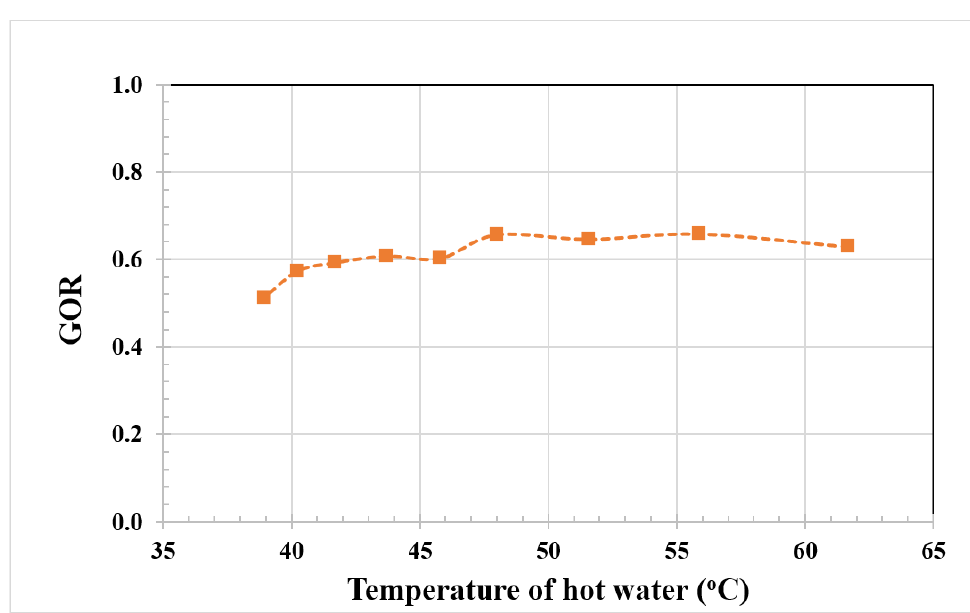
17 of 20 Figure 15. Energy intensity versus hot seawater temperature at two levels of seawater flow rate.